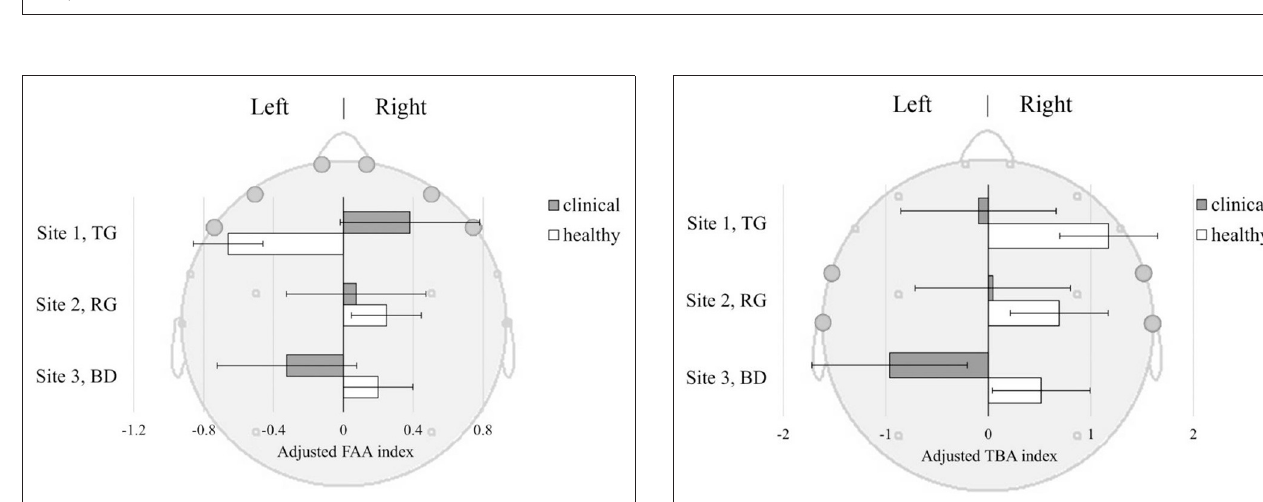
FIGURE 4 | Frontal brain hemodynamics ± SE at different sites (TG, Therapeutic Garden; RG, Residential Green; BD, Busy Downtown); (A) differences in levels of oxy-Hb between sites across all participants, (B) differences in levels of oxy-Hb between sites and groups. All values multiplied by 10,000 to ease depiction and interpretation.